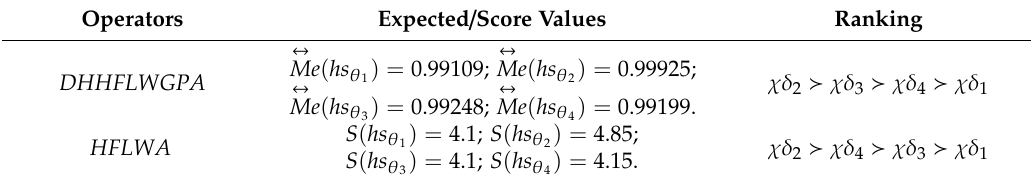
Table 7. The results obtained from di ff erent